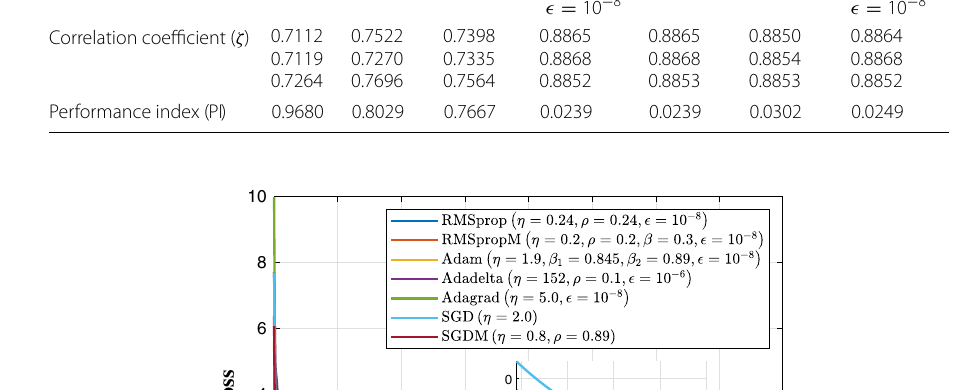
Correlation coefficient ( ζ ) 0.7112